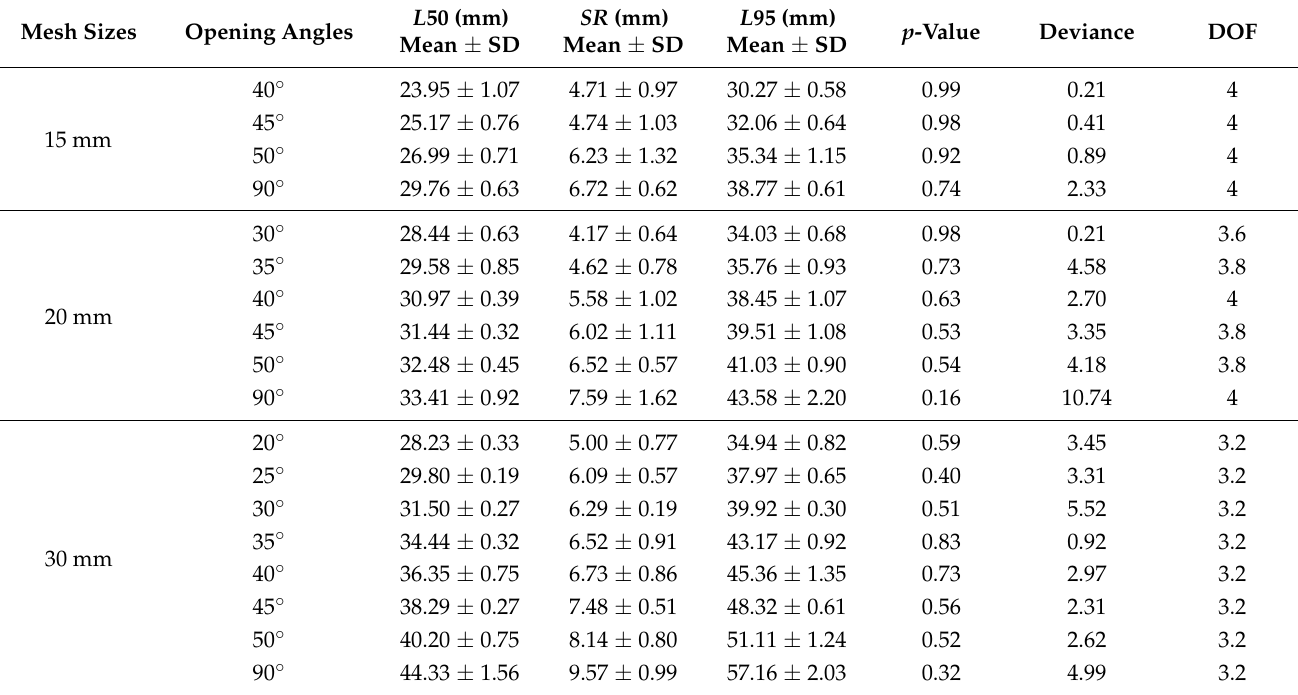
Table 4. Selectivity parameters associated with different mesh sizes and mesh opening angles. Mesh